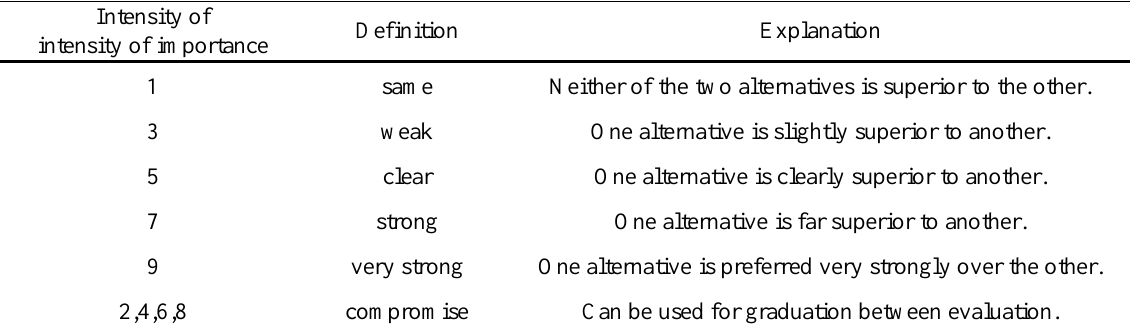
Table 3. Preferences for couple